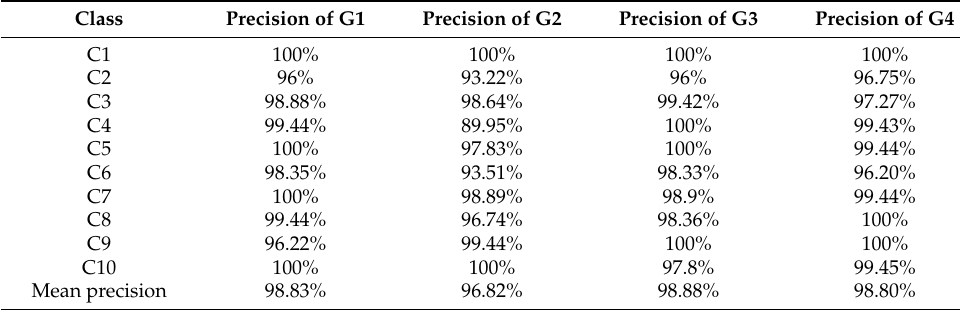
Table 6. Prediction precision of DCNN–SVM for collision localization in Case 1.